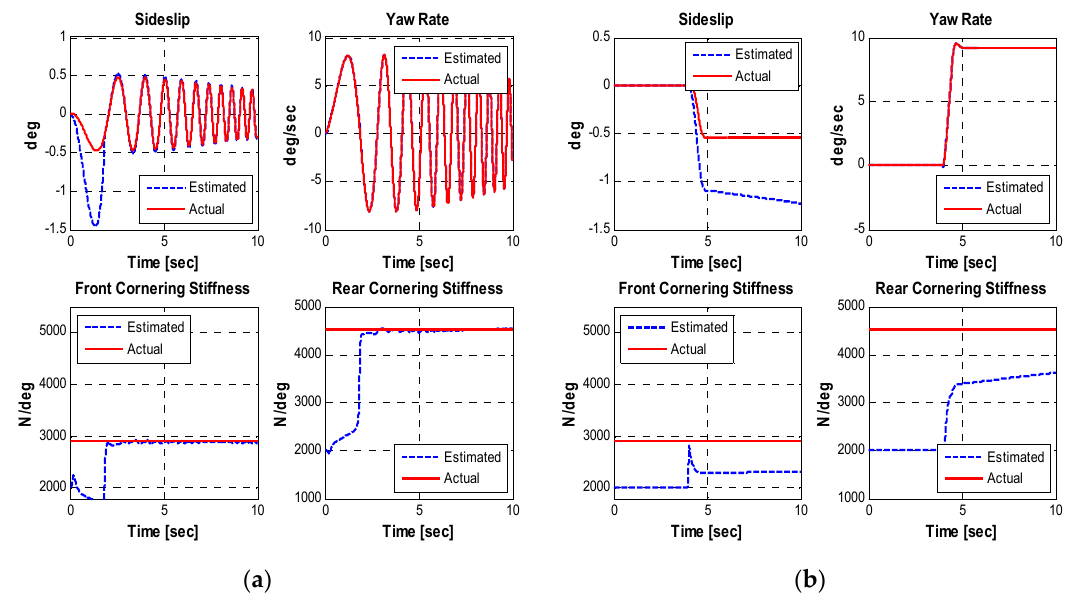
Figure 6. Cornering stiffness observer estimation performance. ( a ) Maneuver: sine-sweep 0.25–4 Hz—good convergence seen. ( b ) Maneuver: steady state circular test—no convergence.